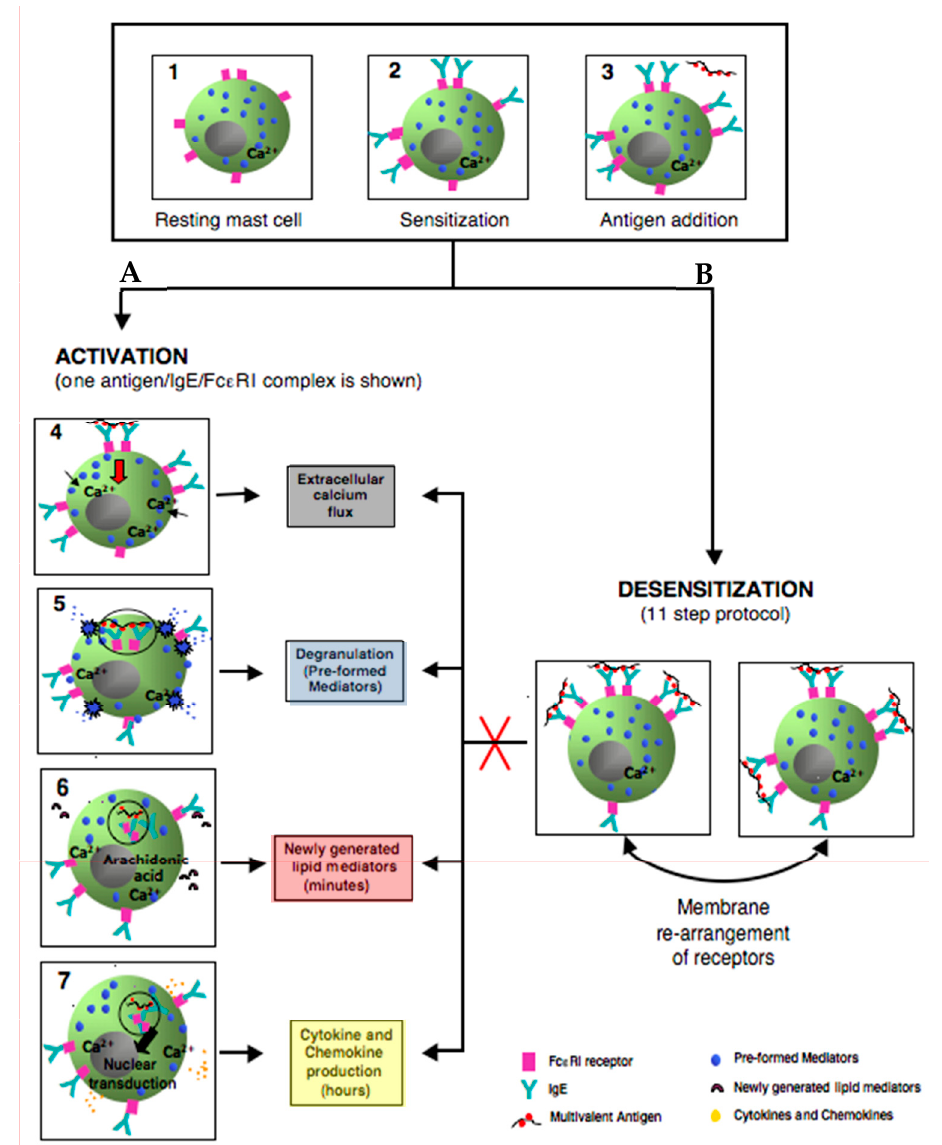
Figure 4. Simplified model comparing the outcomes of activated and rapidly desensitized mast cells. Resting mast cells (1) sensitizes with antigen-specific IgE bound to their high affinity IgE recepors (Fc ε RI) on cell surface (2) A: following the crosslinking of IgE/Fc ε RI receptors with an optimal dose of antigen leads to calcium flux (3–4), degranulation with release of the preformed mediators (5), early de novo synthesis of lipid mediators (6), and late cytokines/chemokines production(7). B: following administrating of suboptimal 11 doses to complete the same optimal dose as in A (activation) (3); leads to membrane rearrangements of receptors which impairs Ag/IgE/Fc ε RI complexes internalization and prevents all the hallmarks of MCs activation (red cross) such as calcium flux, degranulation, lipid mediators, and cytokine production.